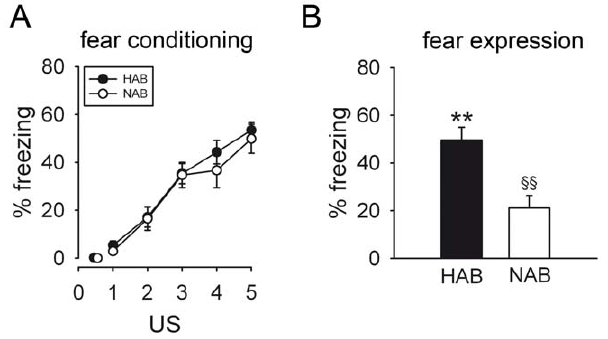
Figure 1. Contextual conditioned fear in HAB and NAB mice. Although freezing behaviour (assessed during each 2-min period